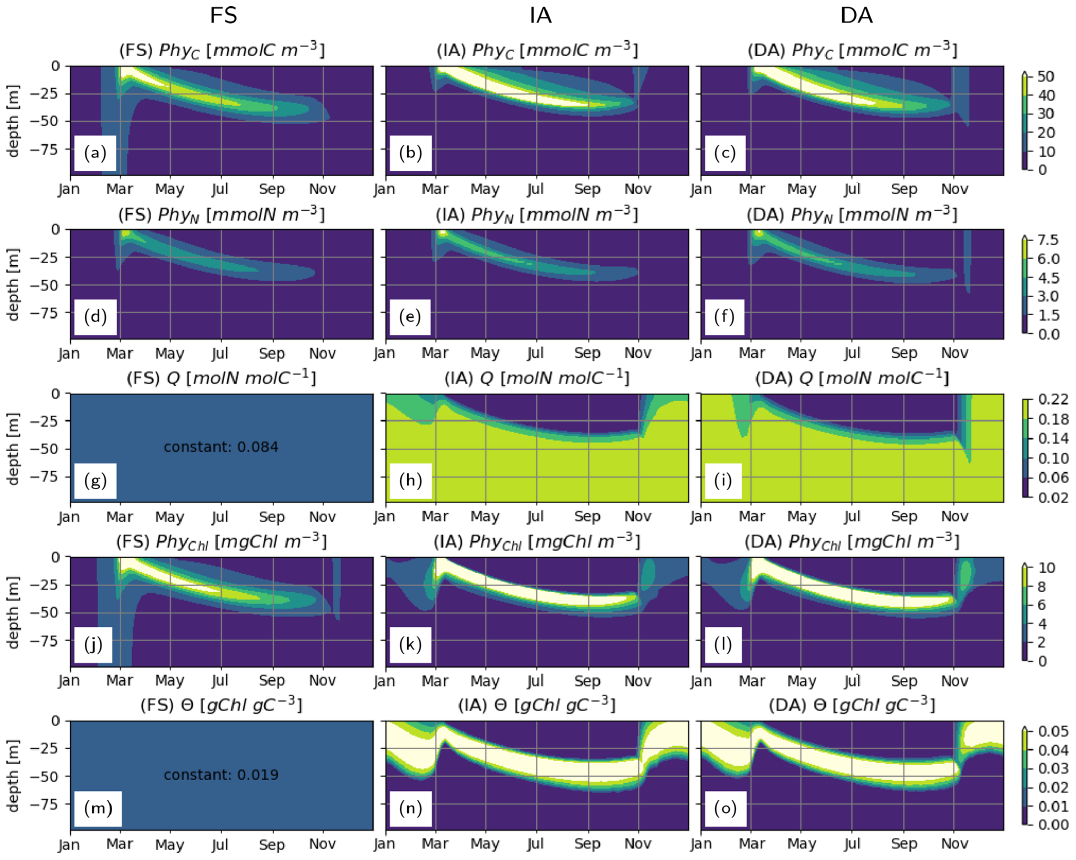
Figure 4. Phytoplankton C, N and Chl concentrations: (a–c) Phy C [mmolCm − 3 ], (d–f) Phy N [mmolNm − 3 ], (j–l) Phy Chl [mgCm − 3 ]; and phytoplankton N : C ( Q ) and Chl : C ( (cid:50) ) ratios: (g–i) Q [molNmolC − 1 ] and (m–o) (cid:50) [gChlgC − 1 ], as simulated by the FS (left); IA (center) and DA (right)